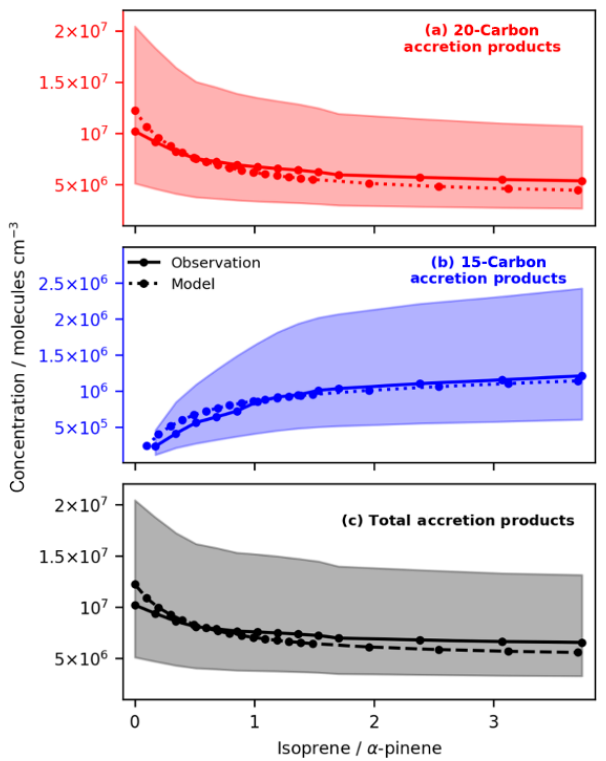
Figure 5. Variation in Simulation B of observed and modelled con- centrations of C20d (a) , C15d (b) and total accretion products (c) with isoprene at fixed initial concentrations of α -pinene (observed data from Berndt et al., 2018a). The modelled data fall within the experimental uncertainty shown by the pale red, blue and grey re- gions. The model reproduces the observed decrease in C20d accre- tion products and increase in C15d accretion products well. Fur- thermore, the model reproduces qualitatively the result observed by McFiggans et al. (2019) that addition of isoprene reduces the total accretion product concentration with potentially important implica- tions for total aerosol burden and particle size